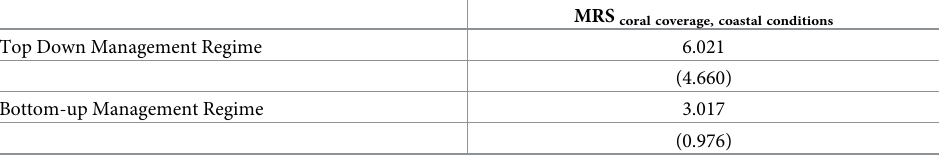
Table 5. Marginal rate of substitution between natural capital and man-made capital for MPAs with top down and bottom-up management